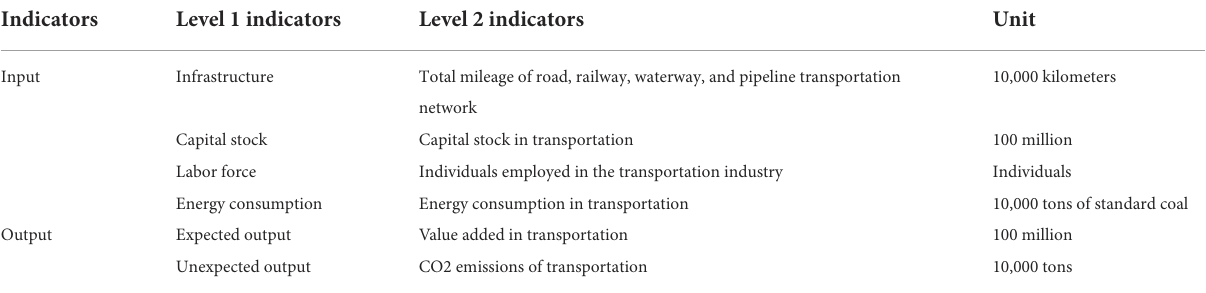
TABLE 1 Transport carbon emission efficiency evaluation index system.